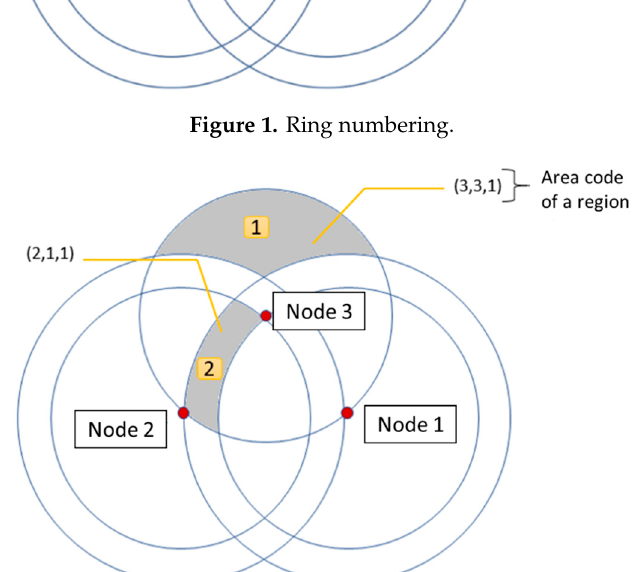
Figure 2. Regions and area codes .